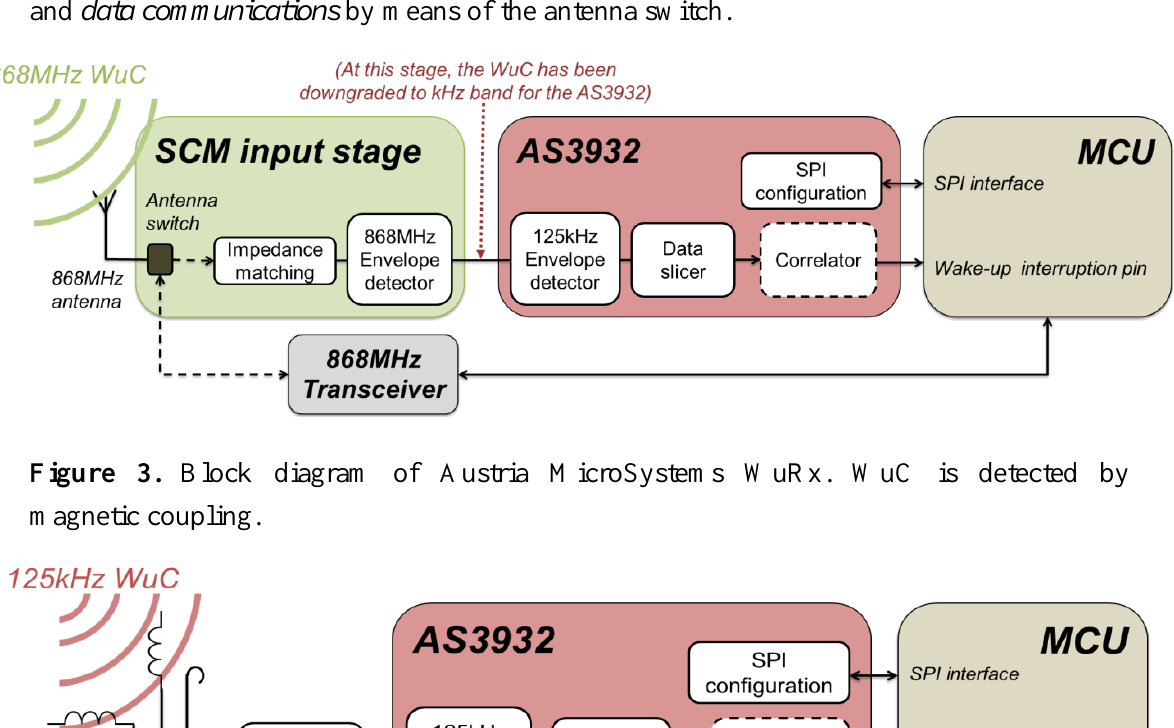
Figure 2. Block diagram of the SCM-WuRx/WuTx. Nodes route Wake-up Calls ( WuC ) and data communications by means of the antenna switch.